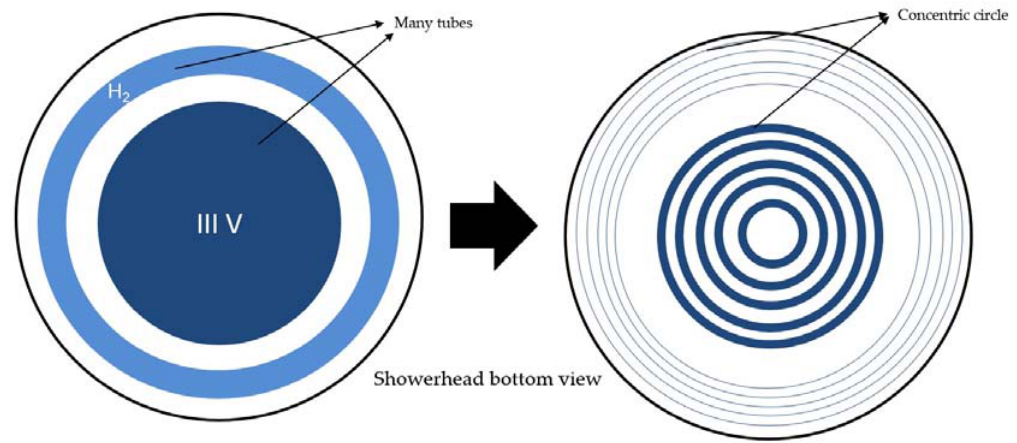
Figure 4. Illustration of the showerhead and its concentric ‐ ring equivalent.